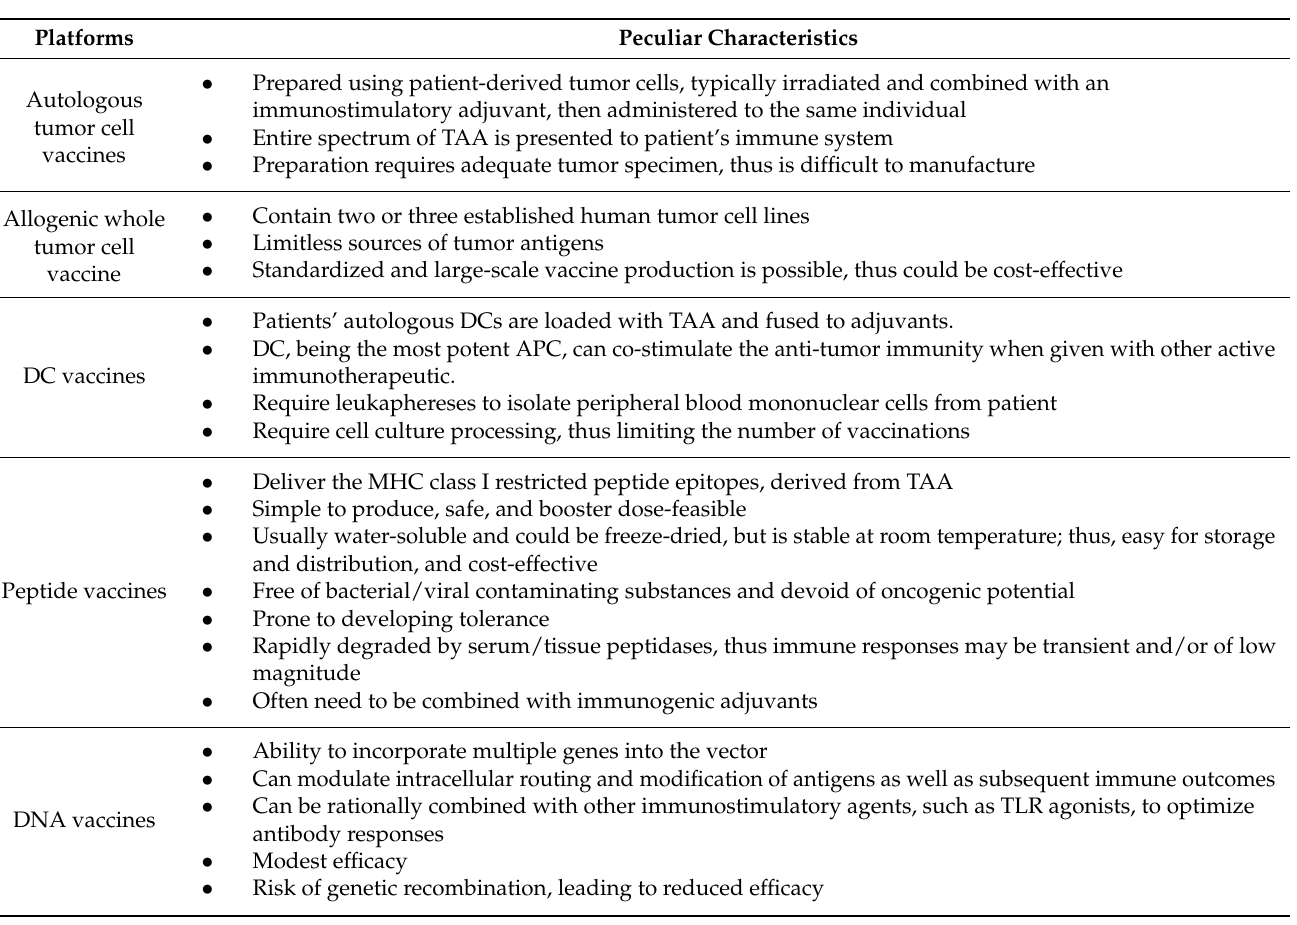
Table 1. Various platforms of therapeutic vaccine